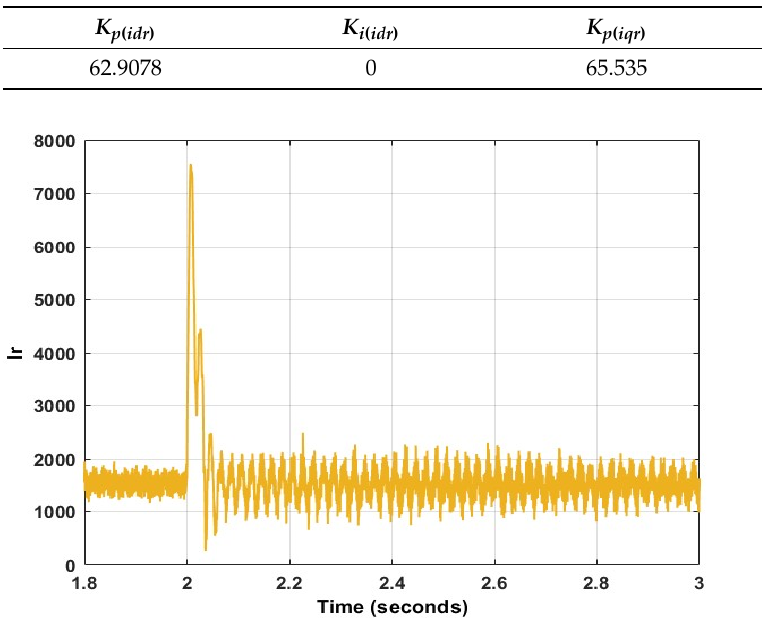
Figure 33. Rotor current transient using PI at 80% dip.